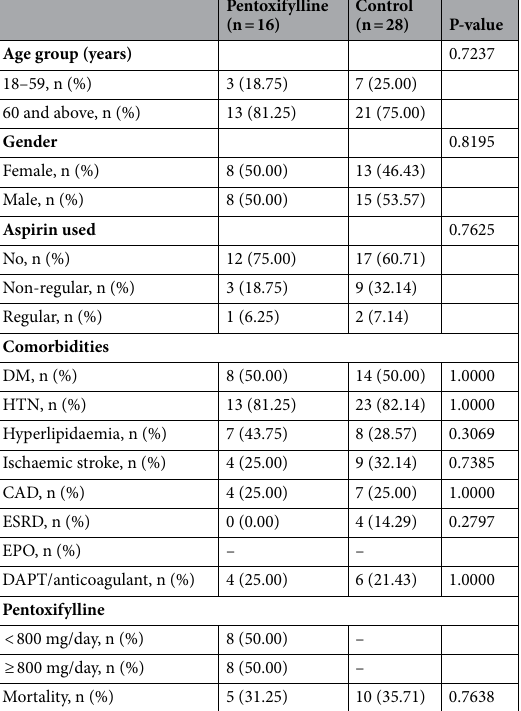
Table 4. Demographic information of patients with intracranial haemorrhage. CAD, coronary artery disease; DAPT, dual antiplatelet therapy; DM, diabetes mellitus; ESRD, end-stage renal disease; EPO, erythropoietin; HTN,